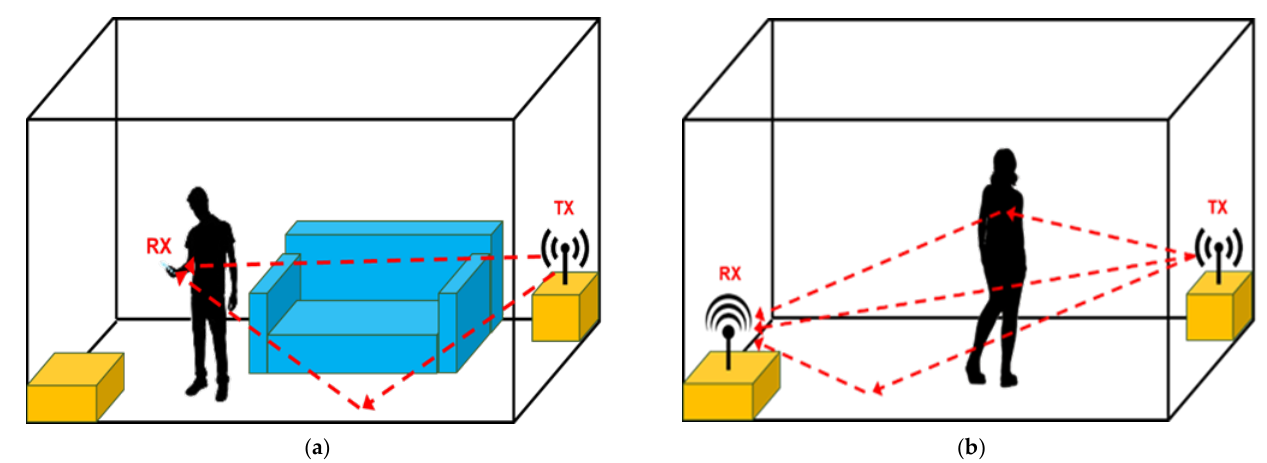
Figure 4. ( a ) . Device-based approach. ( b ) . Device-free approach. Effect of human presence on multipath environment. An RF signal propagates from the transmitter to the receiver via multiple paths, i.e., multipath components. The presence and position of people furtherly affect the multipath environment, while people motion introduces signal frequency shifts, i.e., Doppler effect.